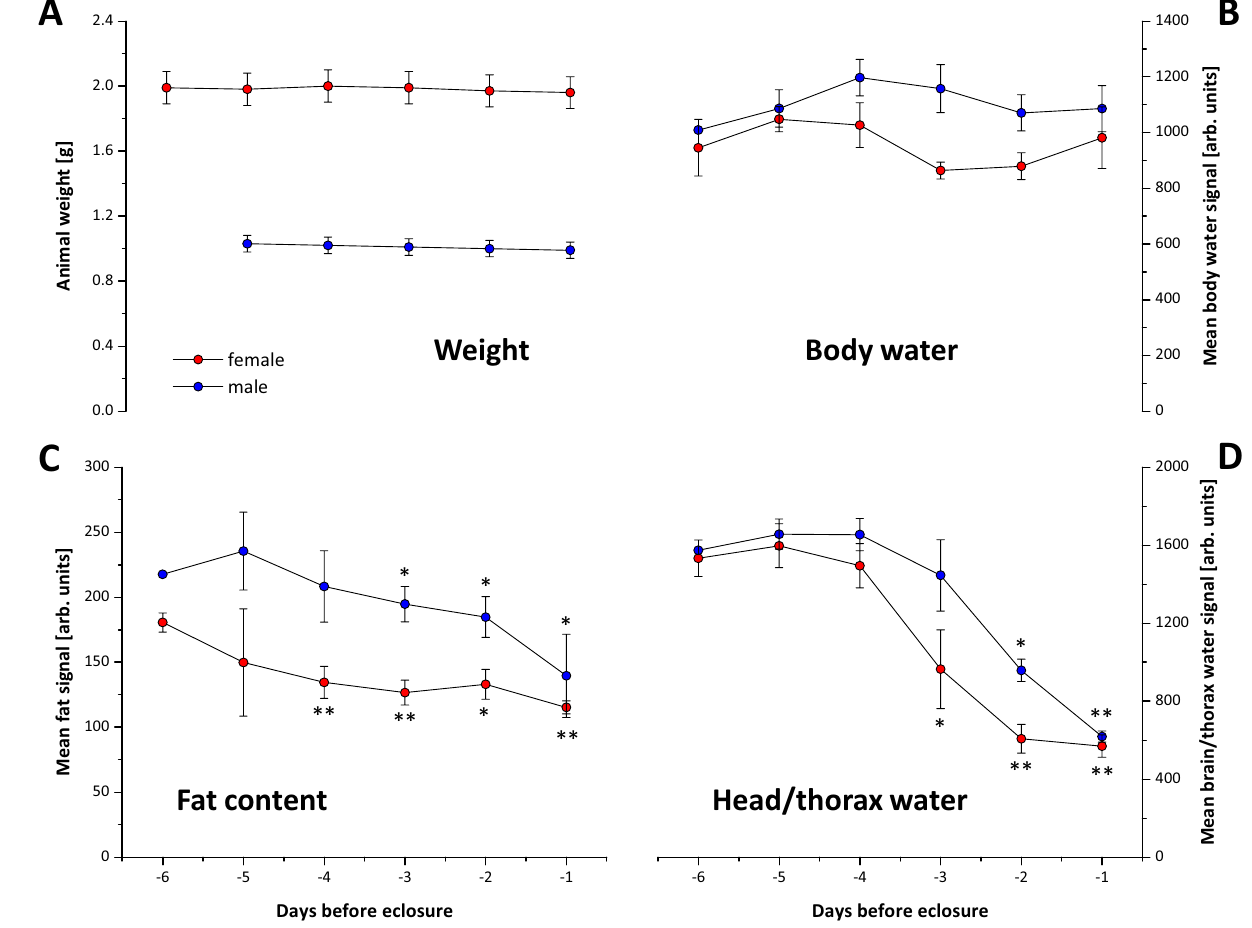
Figure 6. Temporal development of weight, water and fat content of pupae over the observation period. ( A ) weight, ( B ) mean total water signal, ( C ) mean fat signal and ( D ) mean brain/thorax water signal. Data are means ± SD; * = P < 0.05, ** = P < 0.01 vs. day -6 (n=5